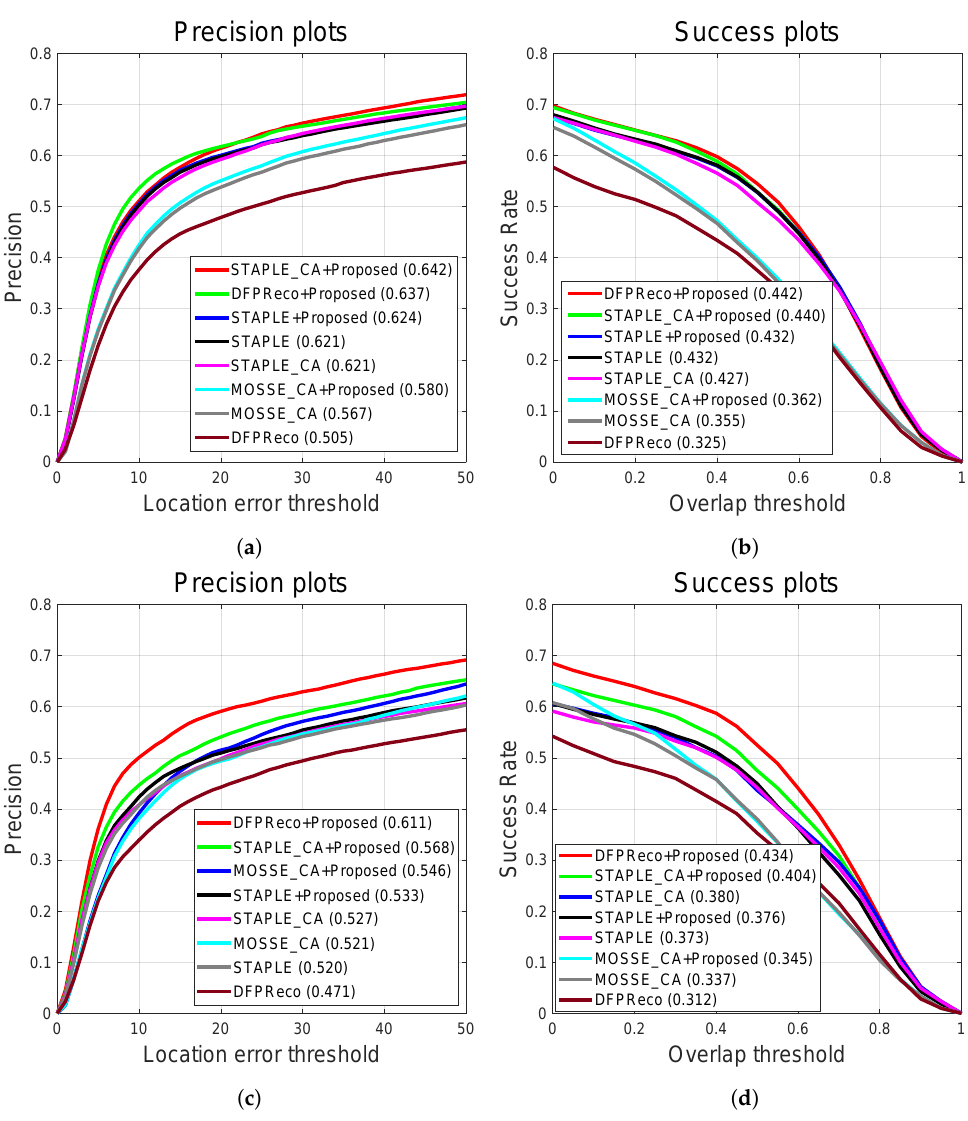
Figure 9. Results of the OPE experiment on the RGB-T234 datasets. ( a , b ) are the precision and success plots on the 234 RGB-T234 video sequences, and ( c , d ) are the precision and success plots on the 89 RGB-T234 video sequences having fast camera motion. Table 2. The improvements of the proposed method compared to the baseline trackers in terms of the number of failures. The red color is the best result, blue the second best, and green the third